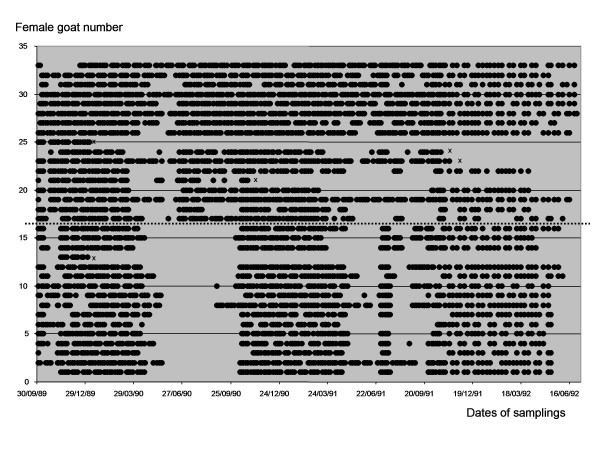
Individual ovulatory activity in Creole goats maintained under two different photoperiodic conditions. Two groups of Creole female goats were maintained in light-proof rooms and subjected to either simulated temperate photoperiodic conditions (TE goats 1-16 at the bottom of the figure, 8 to 16 hours of light per day from winter to summer solstice), or simulated tropical photoperiodic conditions (TR goats 17-33 upper part of the figure, 11 to 13 hours of light per day from winter to summer solstice) for 33 months. Ovulatory activity was assessed by twice-weekly (first 25 months) then once-weekly (last 8 months) determinations of plasma progesterone by radioimmunoassay. One line represents one female goat. A single dot represents one progesterone measurement above 1 ng/ml of plasma and is considered as indicative of the presence of at least one corpus luteum. Female goats which died or were excluded from the experiment are indicated by an "x".